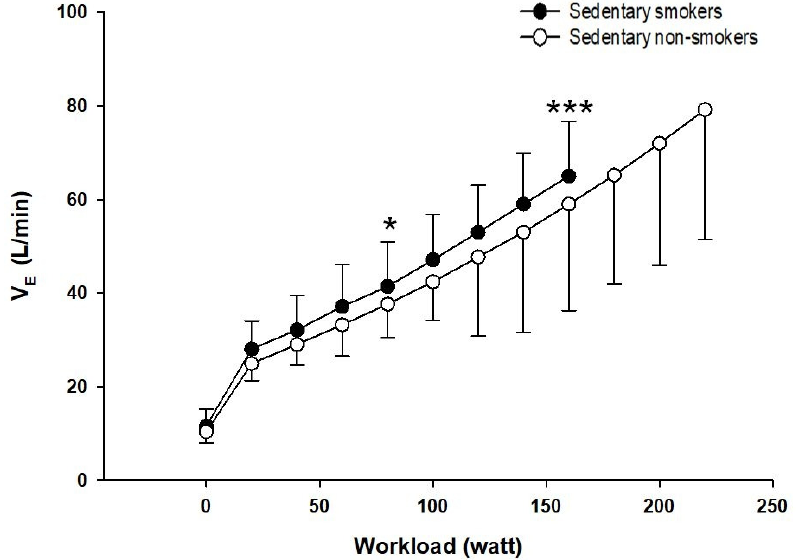
Figure 3. Minute ventilation (VE)at comparable (50, 100, 150 and 200 W) and at maximal workloads in and sedentary non-smokers (white circles) ( n = 25). t -test for independent samples is used for analysis. Sedentary smokers vs. sedentary non-smokers: * p < 0·05; *** p < 0·001.